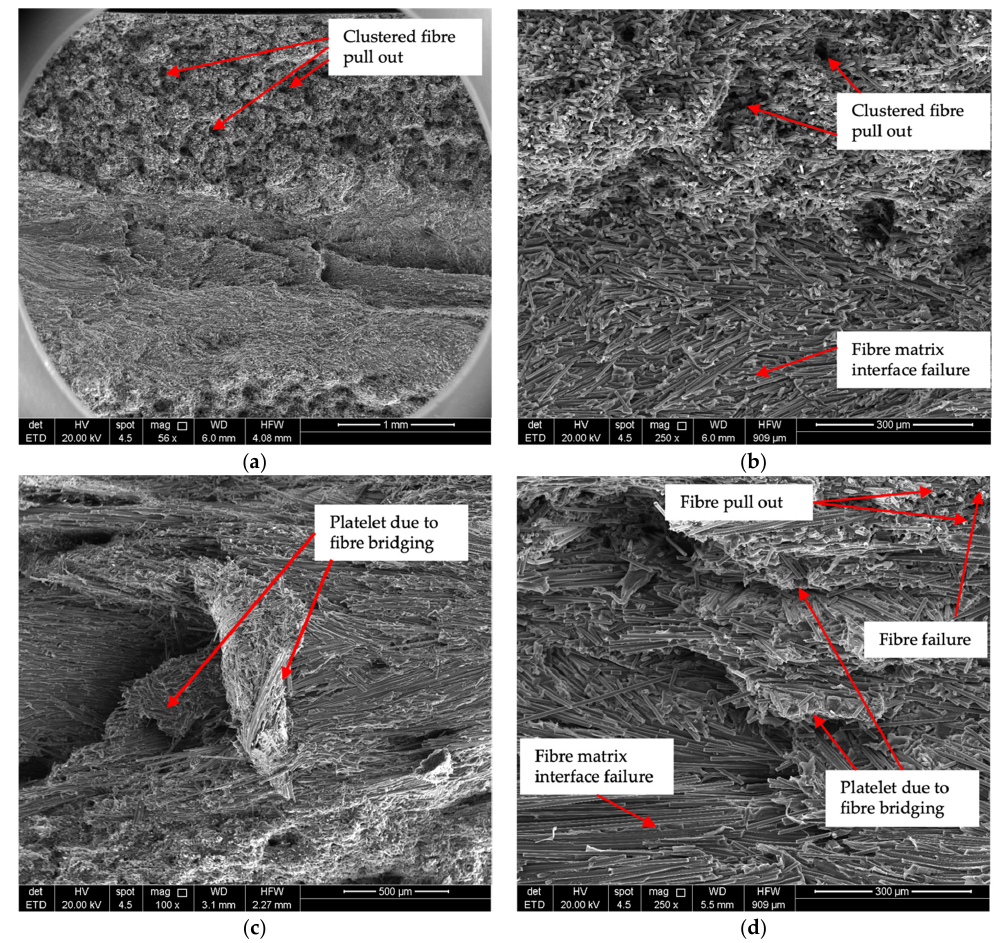
Figure 6. Fatigue fracture surfaces at room temperature under fully reversed loading ( a ) SCF 𝑁 (cid:3033) = 1,968,298 ( b ) SCF 𝑁 (cid:3033) = 32,125 ( c ) LCF 𝑁 (cid:3033) = 17,338 ( d ) LCF 𝑁 (cid:3033) = 411,401.